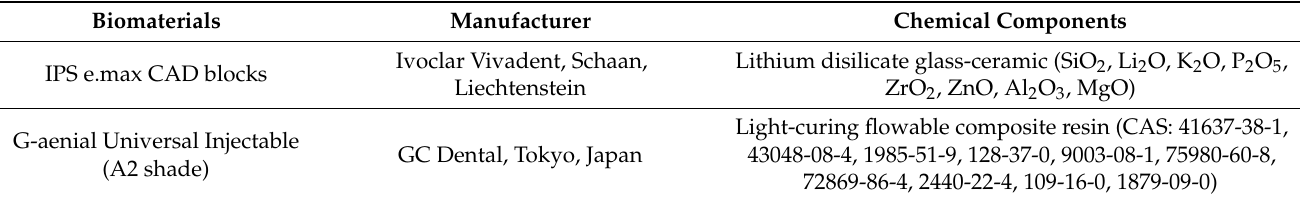
Table 1. Presentation of the biomaterials used in the